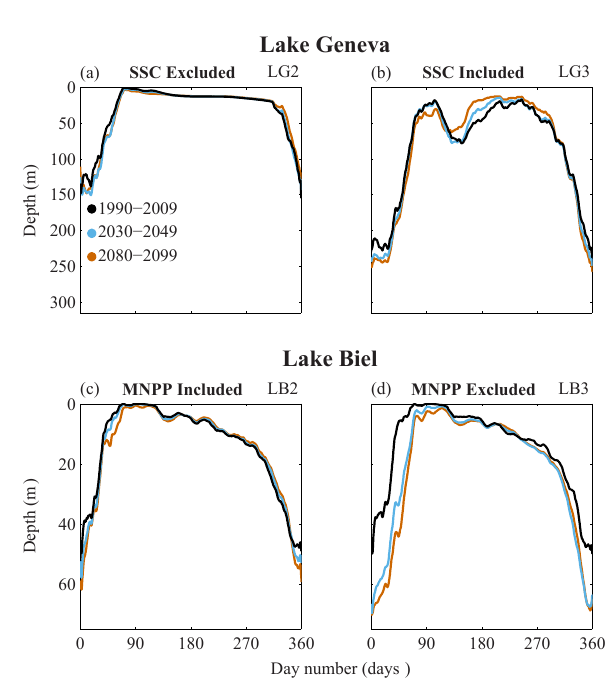
Figure D1. Modeled climate impact on mean river intrusion depth. Reference period (black), near-future (blue) and far-future (orange) time periods for LG (a–b) and LB (c–d) with (b–d) and without (a) river-borne SSC and MNPP thermal input included (c) or ex- cluded (d) from near-future and far-future time periods relative to the reference